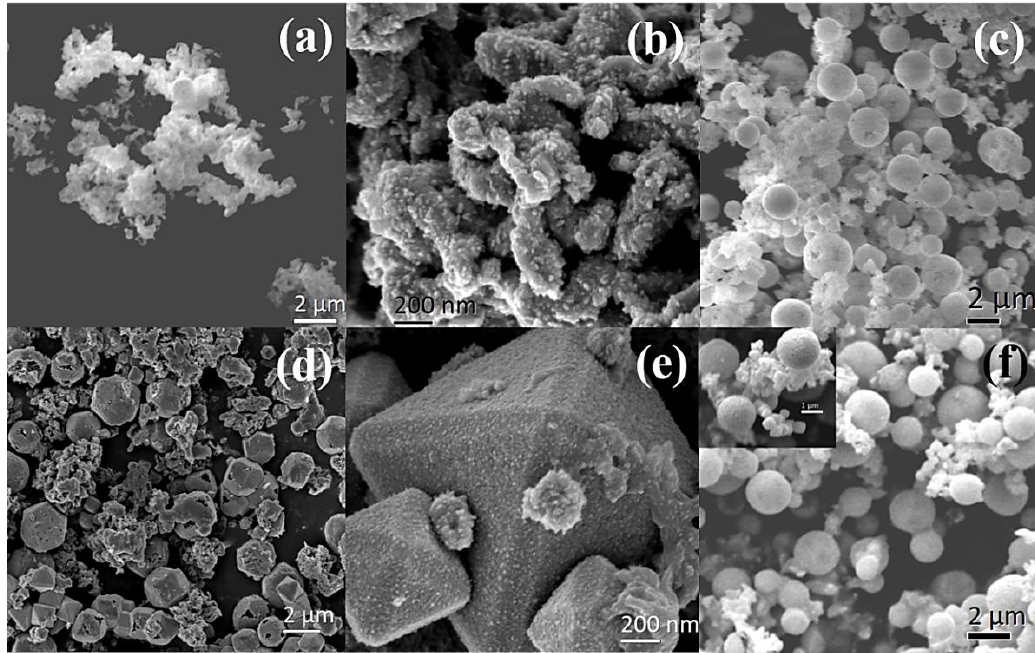
Figure 2. SEM images of ( a , b ) Cu-24, ( c ) Cu-3, ( d ) and ( e ) Cu-6, ( f ) Cu-12 (the inset is a higher magnification image of all the 3 morphologies, i.e., powder, sphere and cube).